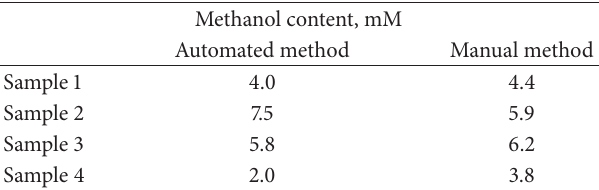
Table 3: Comparison between the automated and the manual